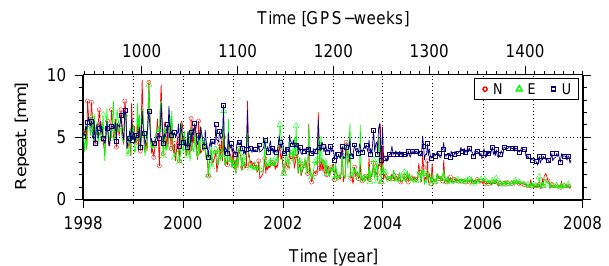
Fig. 1. Global distribution of TIGA and IGS tracking stations used for reprocessing.